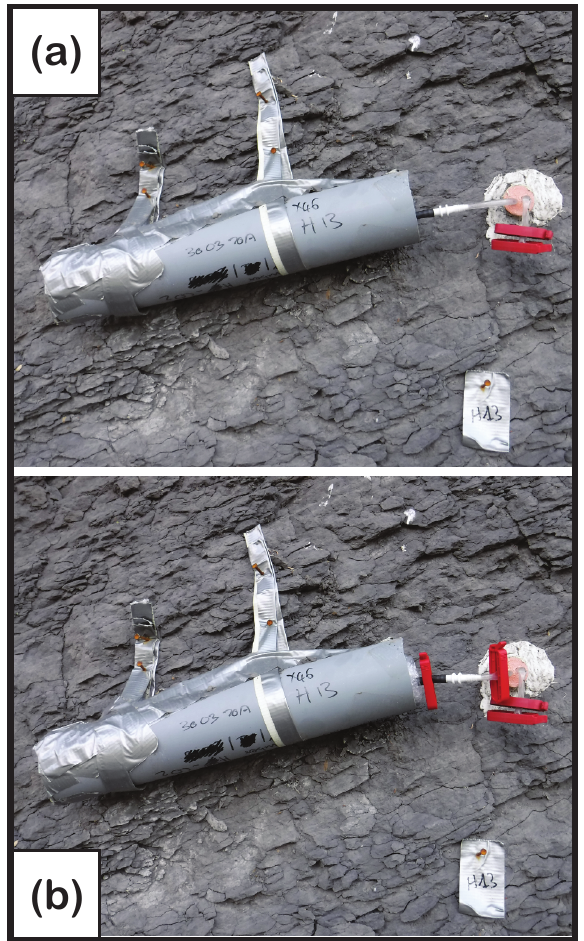
Figure 4. (a) Zeolite molecular sieve connected to a chamber for passive CO 2 trapping. The zeolite molecular sieve is encased in the grey PVC tubing and connected for months to the chamber using a white connector. (b) Zeolite molecular sieve ready to be discon- nected from chamber. The red clips are positioned so that they seal both the zeolite molecular sieve and the